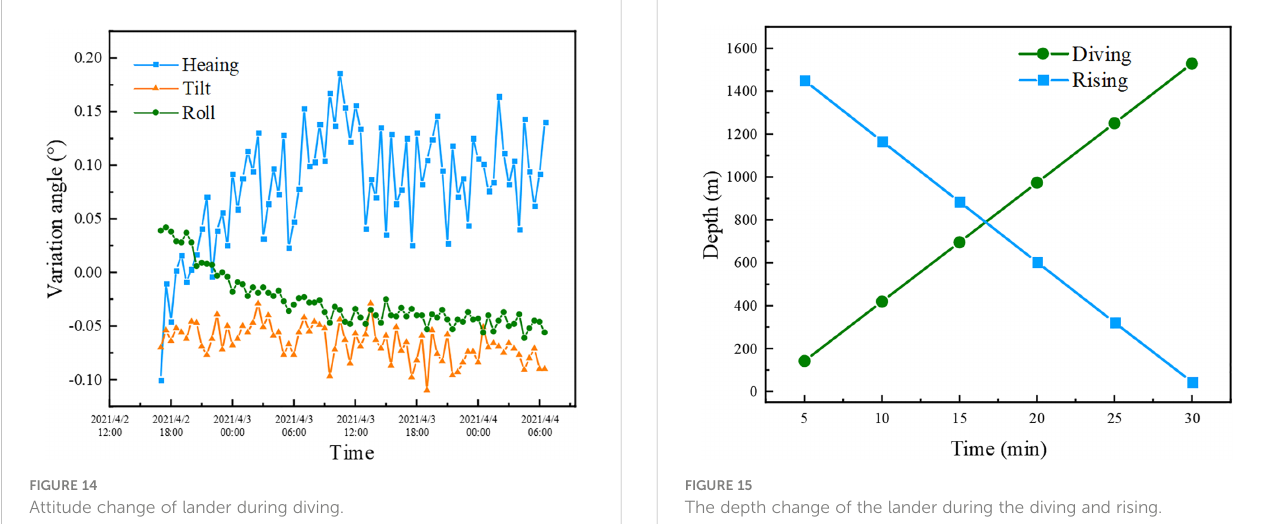
FIGURE 14 Attitude change of lander during diving.